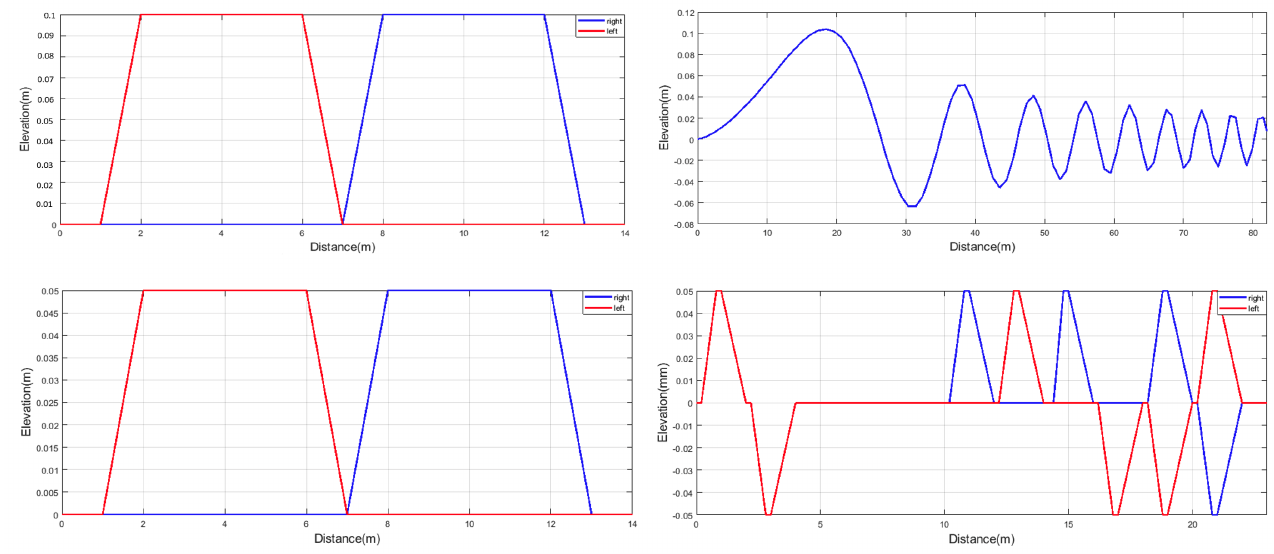
Figure 4. Road irregularities.